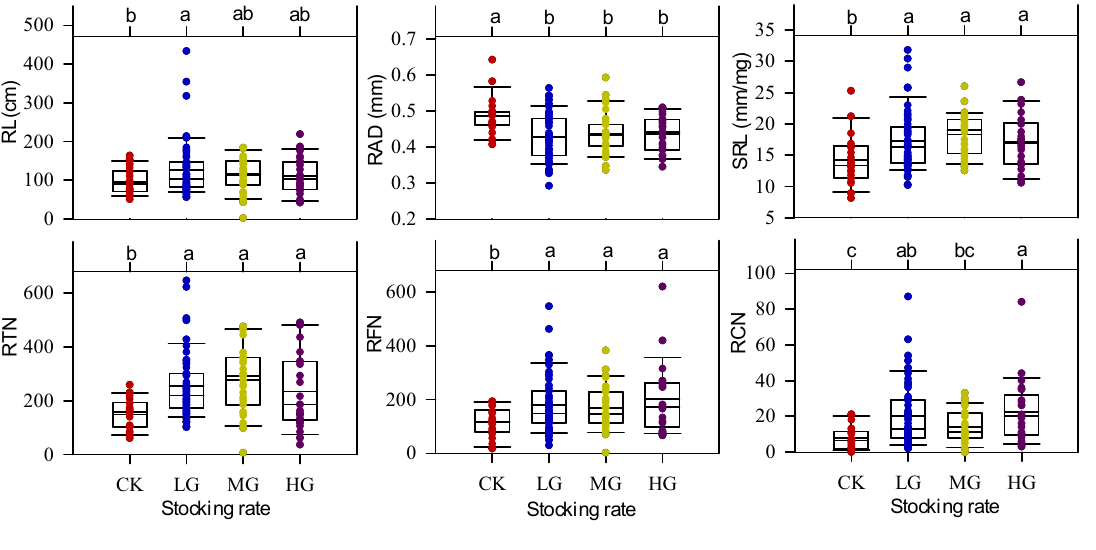
Figure 5 Root traits of tillering Stipa breviflora individuals under four stocking rates. RAD – root average diameter; SRL – specific root length; RL – total root length; RFN – root furcation number; RTN – root tip number; RCN – root crossing number; CK – nongrazed; LG – lightly grazed (0.91 sheep unit hm − 2 half year − 1 ); MG – moderately grazed (1.82 sheep unit hm − 2 half year − 1 ); HG – heavily grazed (2.71 sheep unit hm − 2 half year − 1 ).